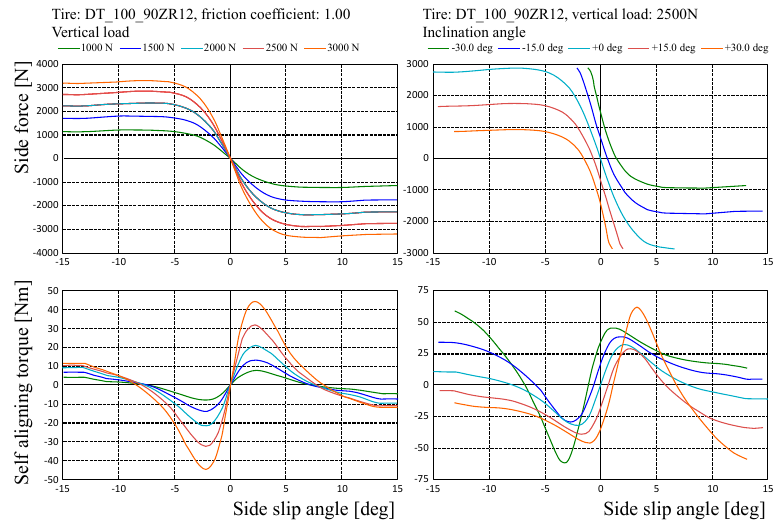
Figure 5. Motorcycle tire model is used in CarMaker.